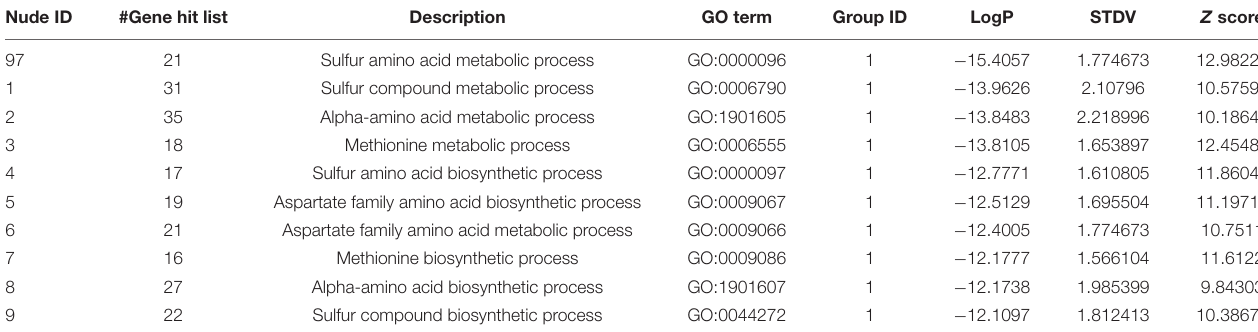
TABLE 1 | The information of the nudes clustered in Figure 3D .